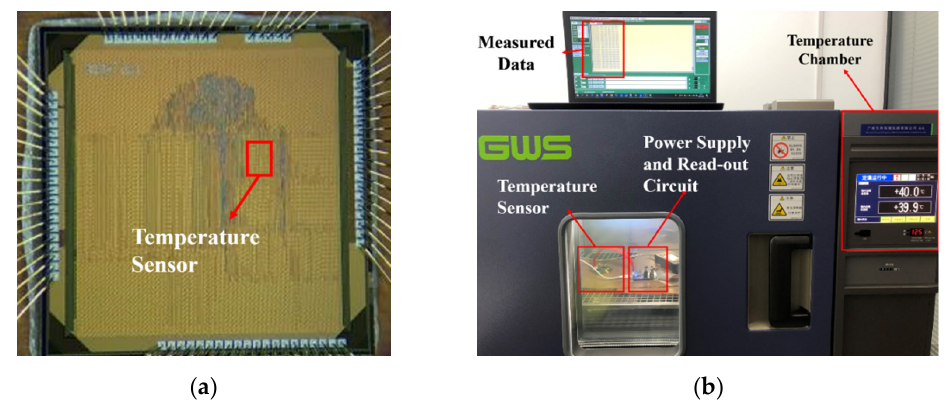
Figure 16. ( a ) Die micrograph; ( b ) testing environment.